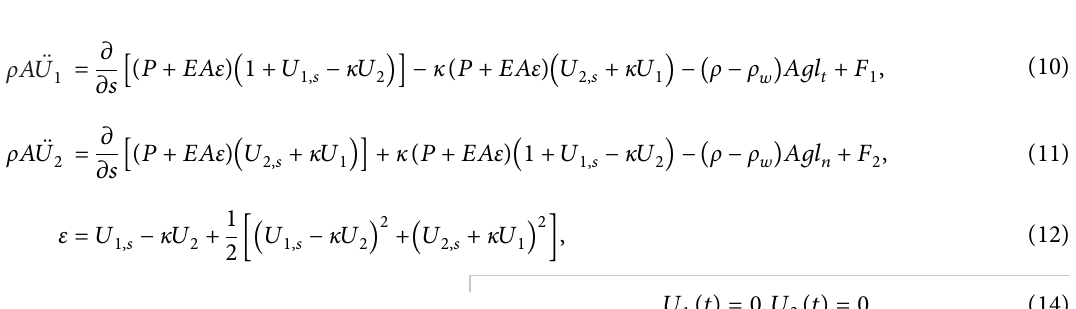
Figure 2: Schematic diagram of mooring line